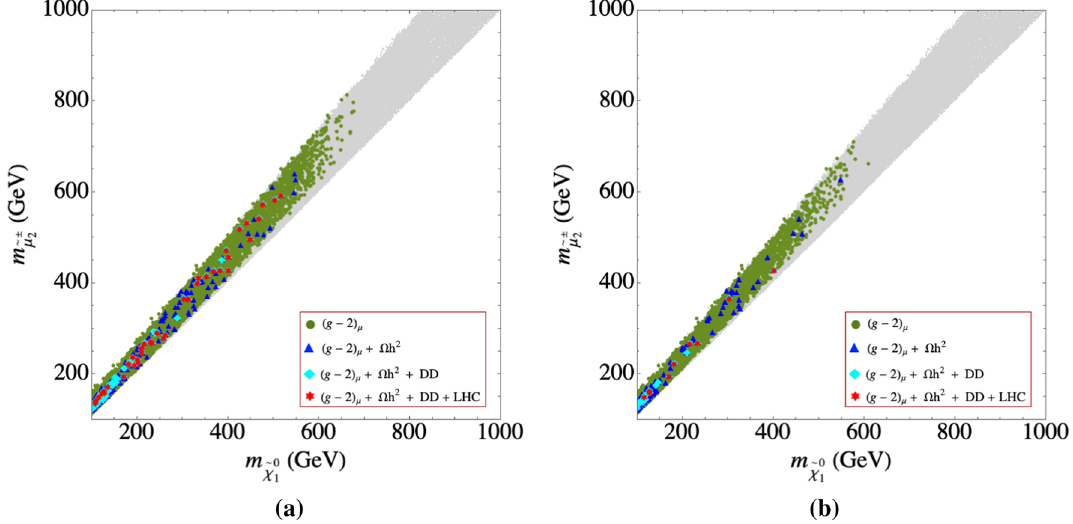
Fig. 11 The results of our parameter scan in the m ˜ χ 0